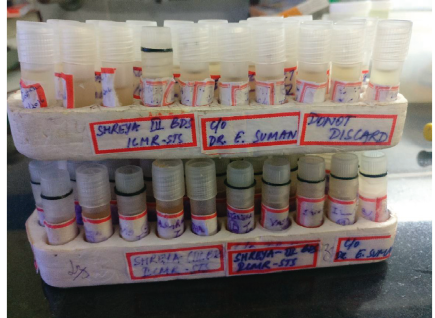
Figure 1: Preserved samples.